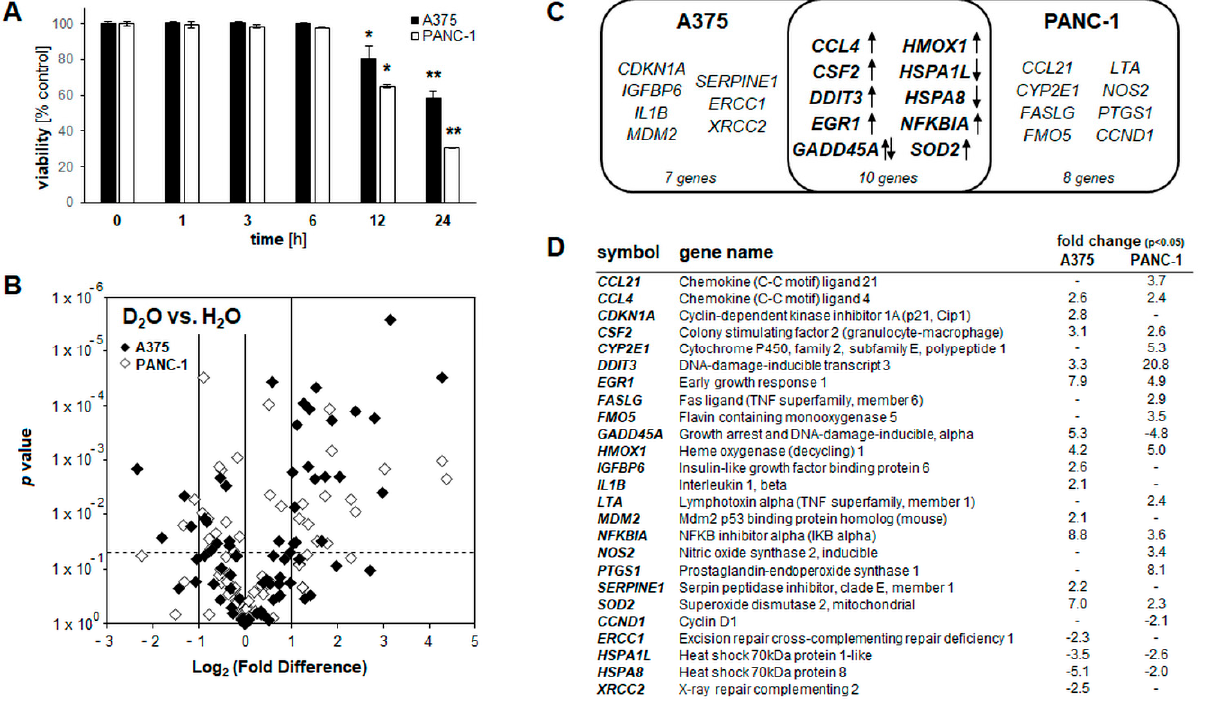
Figure 3. D 2 O-induced early stress response gene expression comparing melanoma (A375) and pancreatic ductal adeno- carcinoma (PANC-1) cells. ( A ) Time-course analysis of cell viability impairment assessed by flow cytometry (performed as in Figure 1A) in A375 and PANC-1 cells cultured in 90% D 2 O ( ≤ 24 h; n = 3; p * < 0.05; p ** < 0.01). ( B ) Volcano plot depicting differential gene expression (untreated versus D 2 O-exposed (90%, 6 h)) as identified by the Human Stress and Toxicity PathwayFinder TM PCR Array technology (cut off criteria: expression differential >2; p -value ≤ 0.05; n = 3; A375 (black diamond); PANC-1 (empty diamond). ( C ) Comparative gene expression array analysis in Venn diagram depiction; in the overlapping region, single arrow indicates congruent up- or downregulation, and double arrows indicate opposing expression changes between cell lines. ( D ) Comparative gene expression array analysis with total number of genes per group as summarized numerically (A375 vs. PANC-1; D 2 O exposed as in panel B).